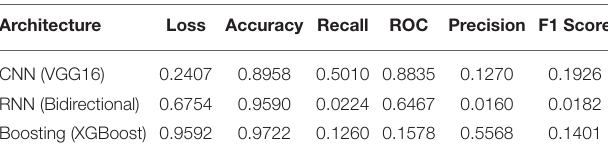
TABLE 4 | Values of best performance metrics of CNN, RNN, and XG-Boost with one epoch.